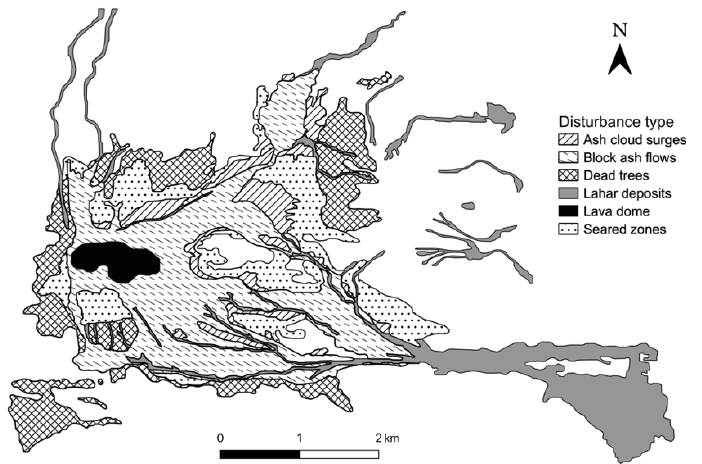
Figure 2. Map of the 1990–1995 eruption deposits and disturbances, based on aerial photographs taken on 18 September 1995, adapted and digitized from [47].